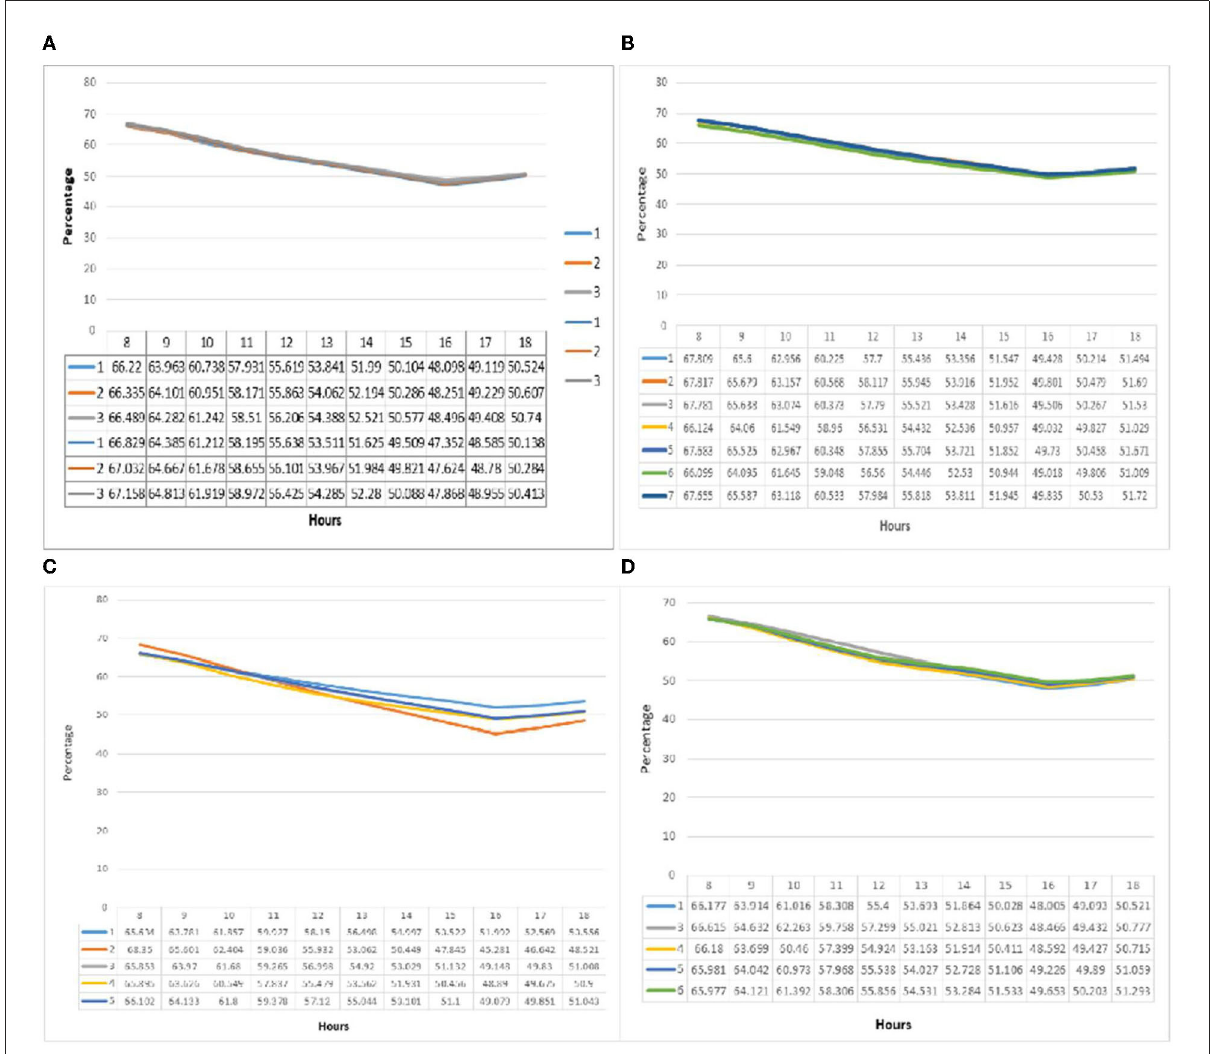
FIGURE5 (A–D) Relative humidity comparison diagrams from point B in all groups,